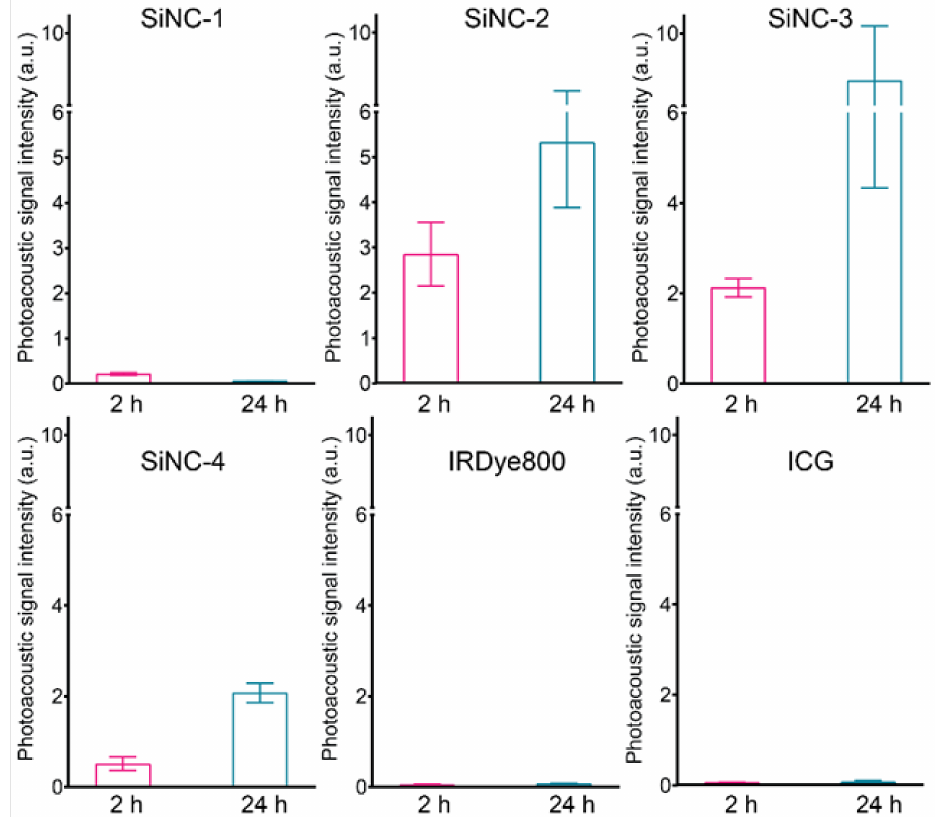
Figure 7. Comparison of photoacoustic signal intensity from Cal 27 cell phantoms incubated with the different dyes for either 2 h (magenta histograms) or 24 h (cyan histograms). PA signal intensity of SiNC(1–4), IRDye800 and ICG treated cells recorded at 880 nm, 775 nm, and 780 nm,